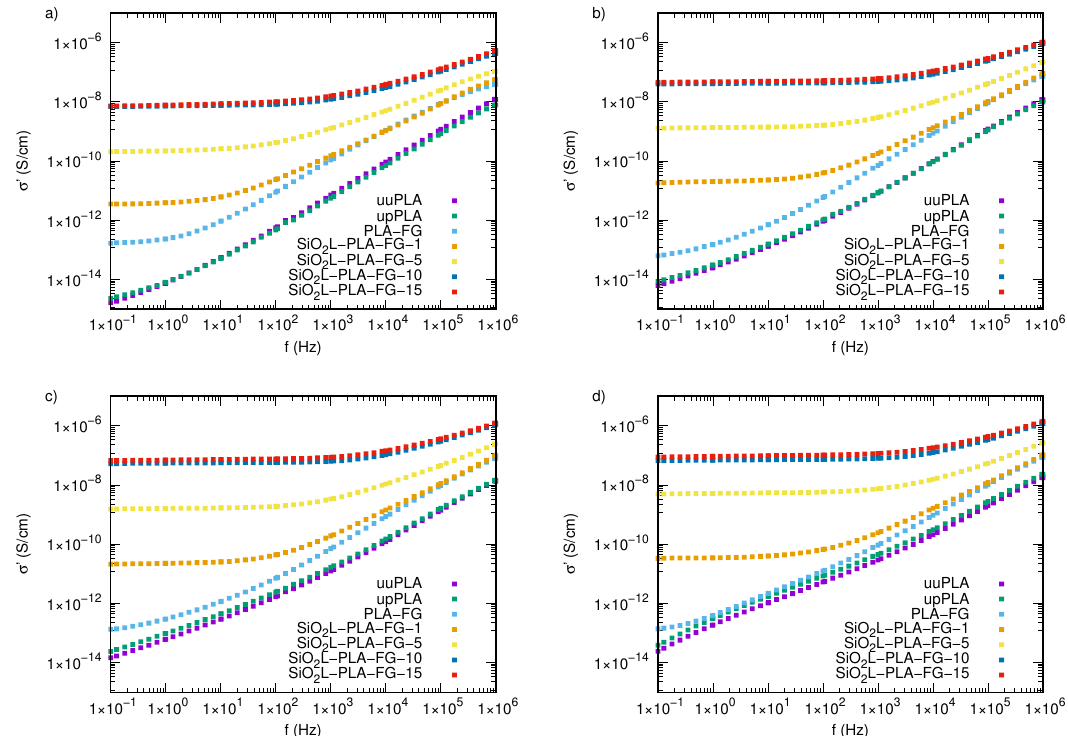
Figure 7. The real part of the complex conductivity of silicon-dioxide–lignin nanocomposites as a function of frequency for ( a ) 293.15 K, ( b ) 323.15 K, ( c ) 328.15 K, and ( d ) 333.15